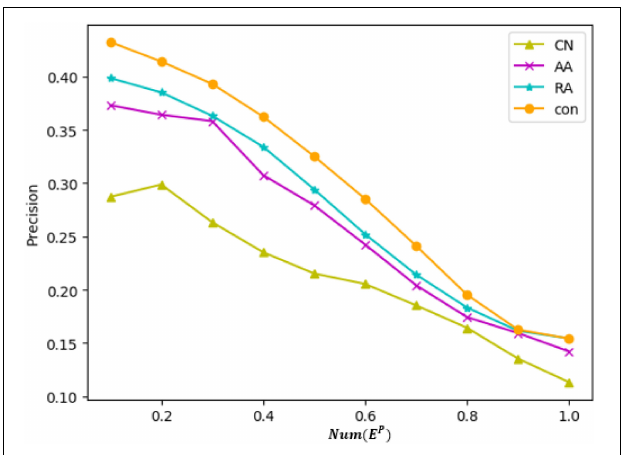
FIGURE 12 | AUC comparison of different models.